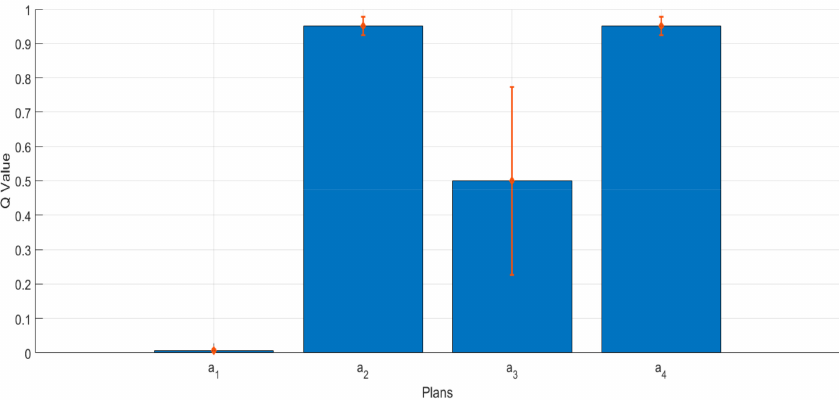
Figure 5. Analysis of the v value’s effect on the Q i values of each expropriator’s